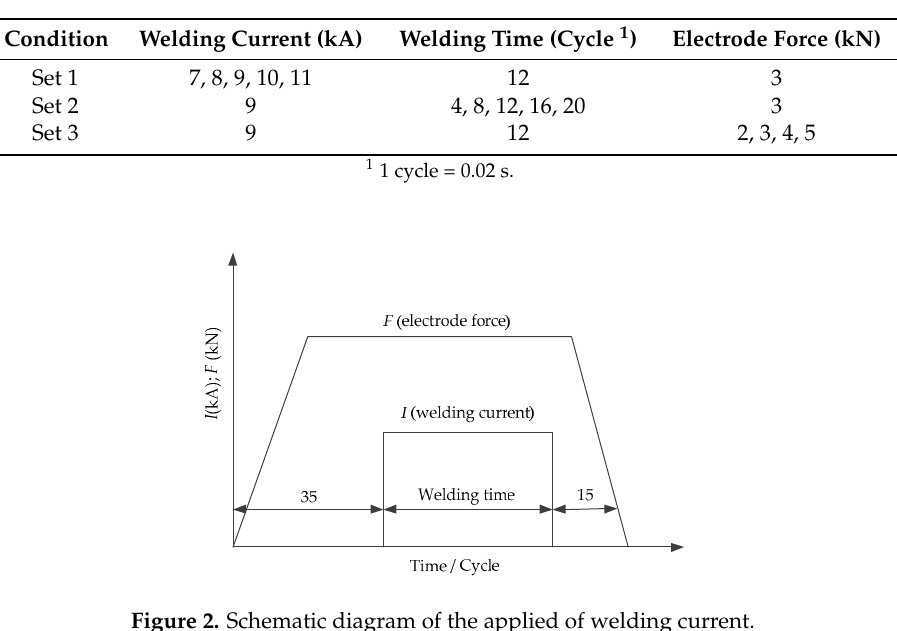
Table 2. Experimental conditions.